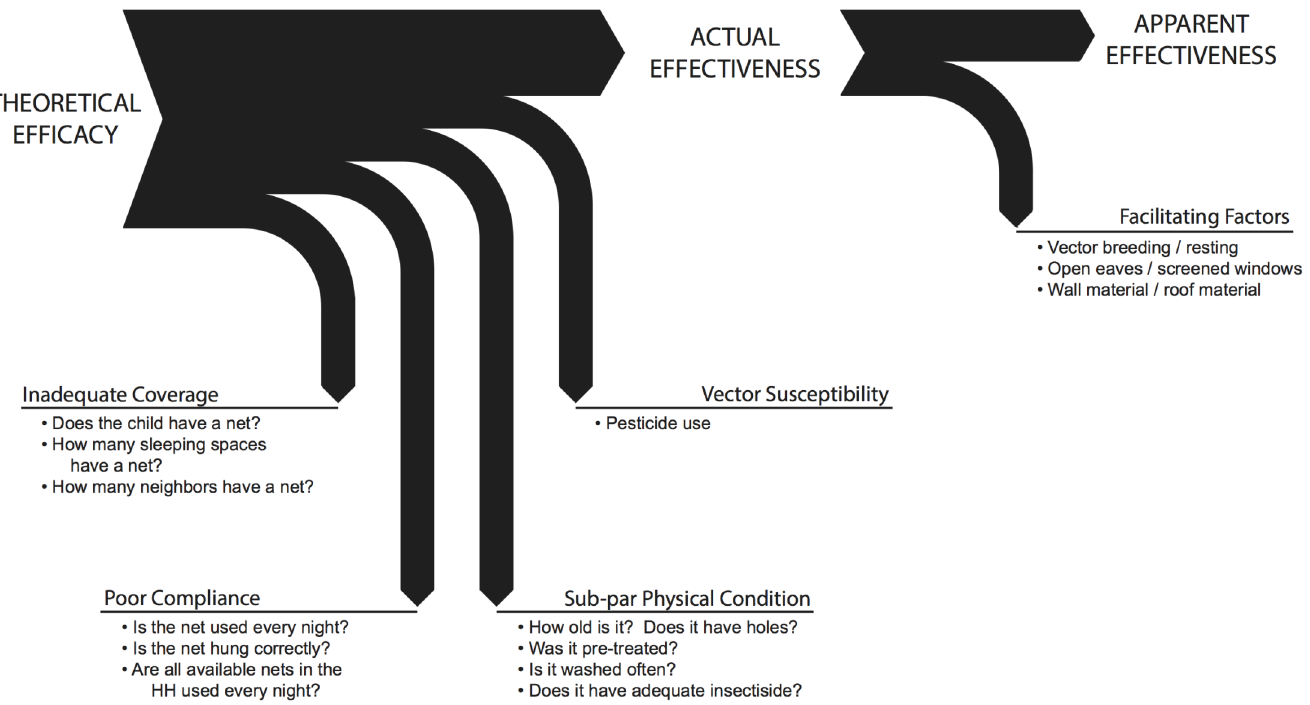
Fig 1. Diagram of the efficacy decay of prevention. Effectiveness of ITNs is threatened by five domains: inadequate coverage, poor compliance, poor physical condition and reduced vector susceptibility. In addition, facilitating factors can further reduce the apparent effectiveness measured under real-world